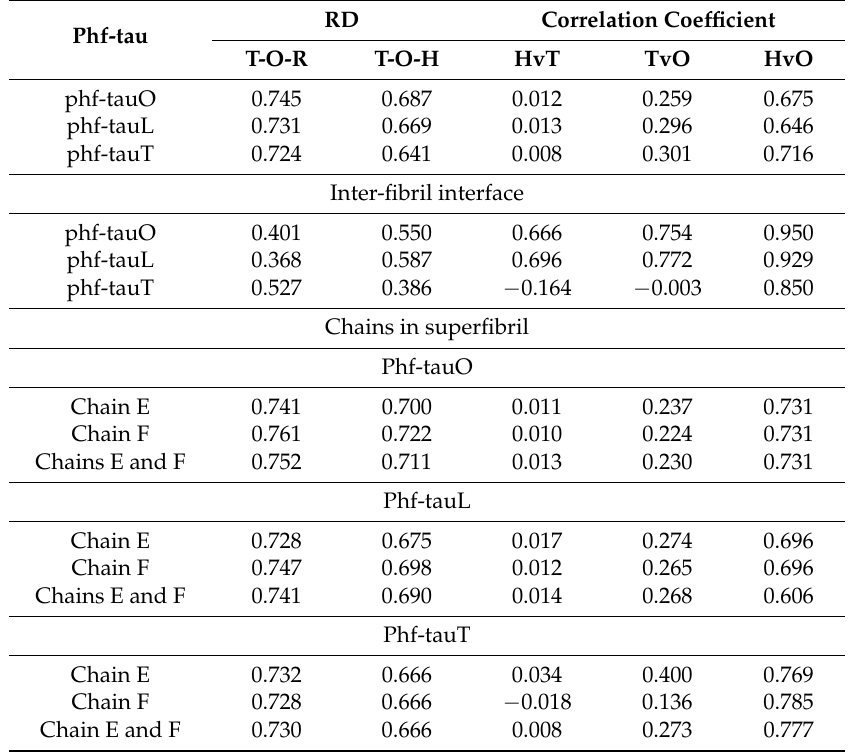
Table 1. Relative Distance (RD) values and correlation coefficients computed for the superfibril, proto-fibrils and individual chains treated as components of the